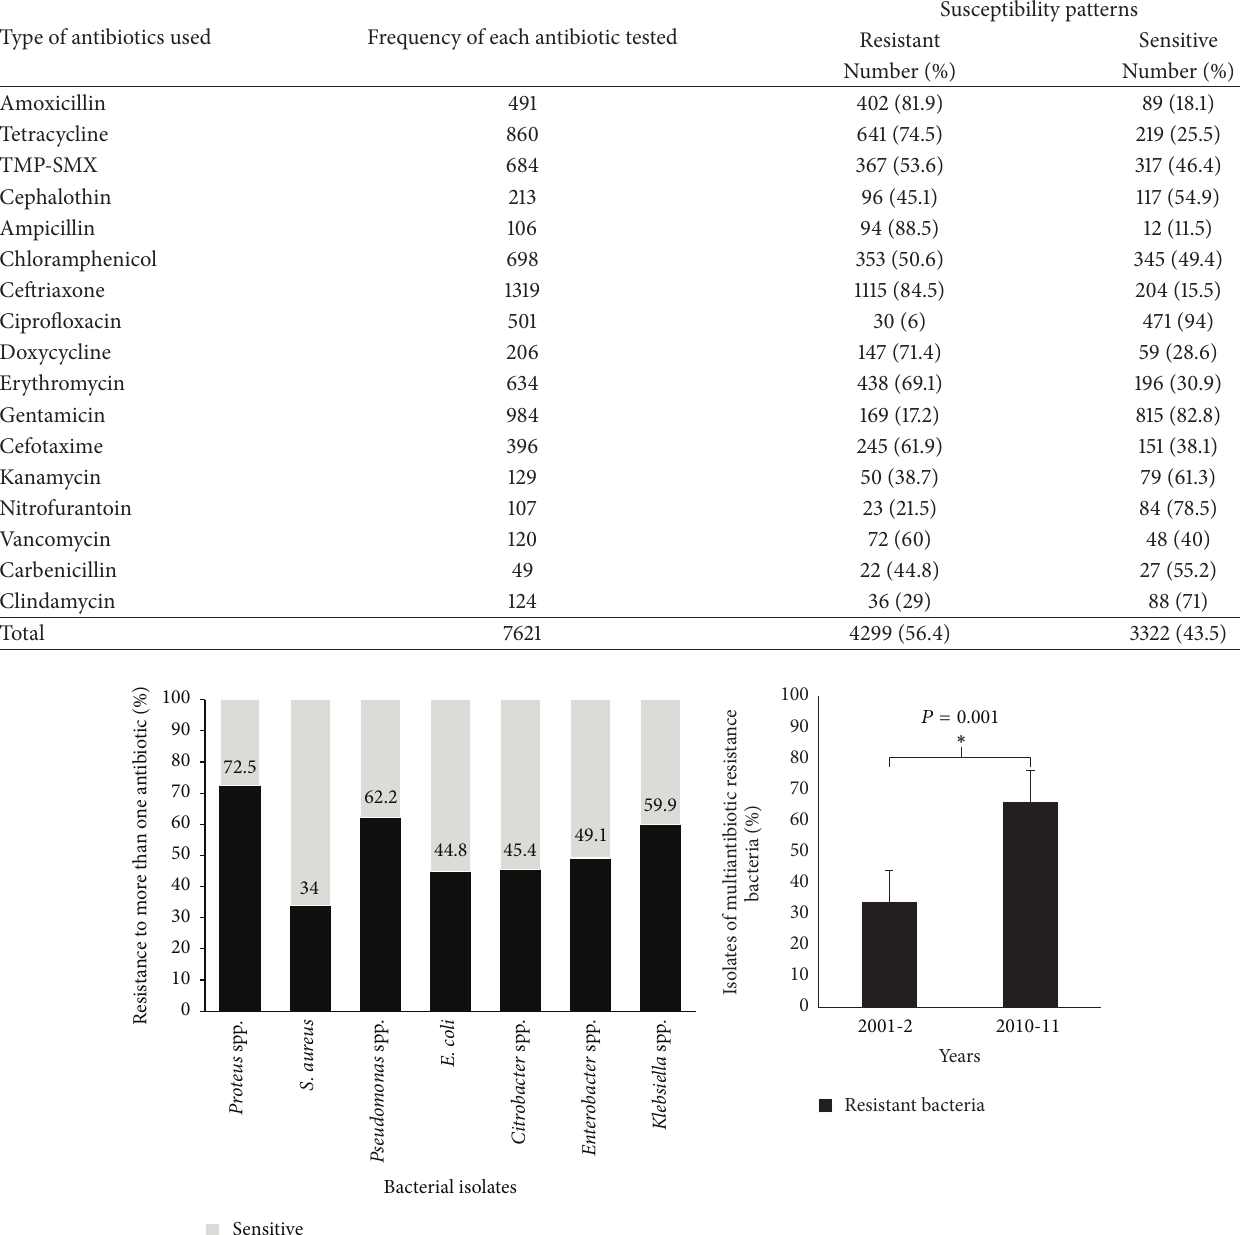
Table 3: Overall antibiotic susceptibility profiles of isolated bacteria from ear discharge.